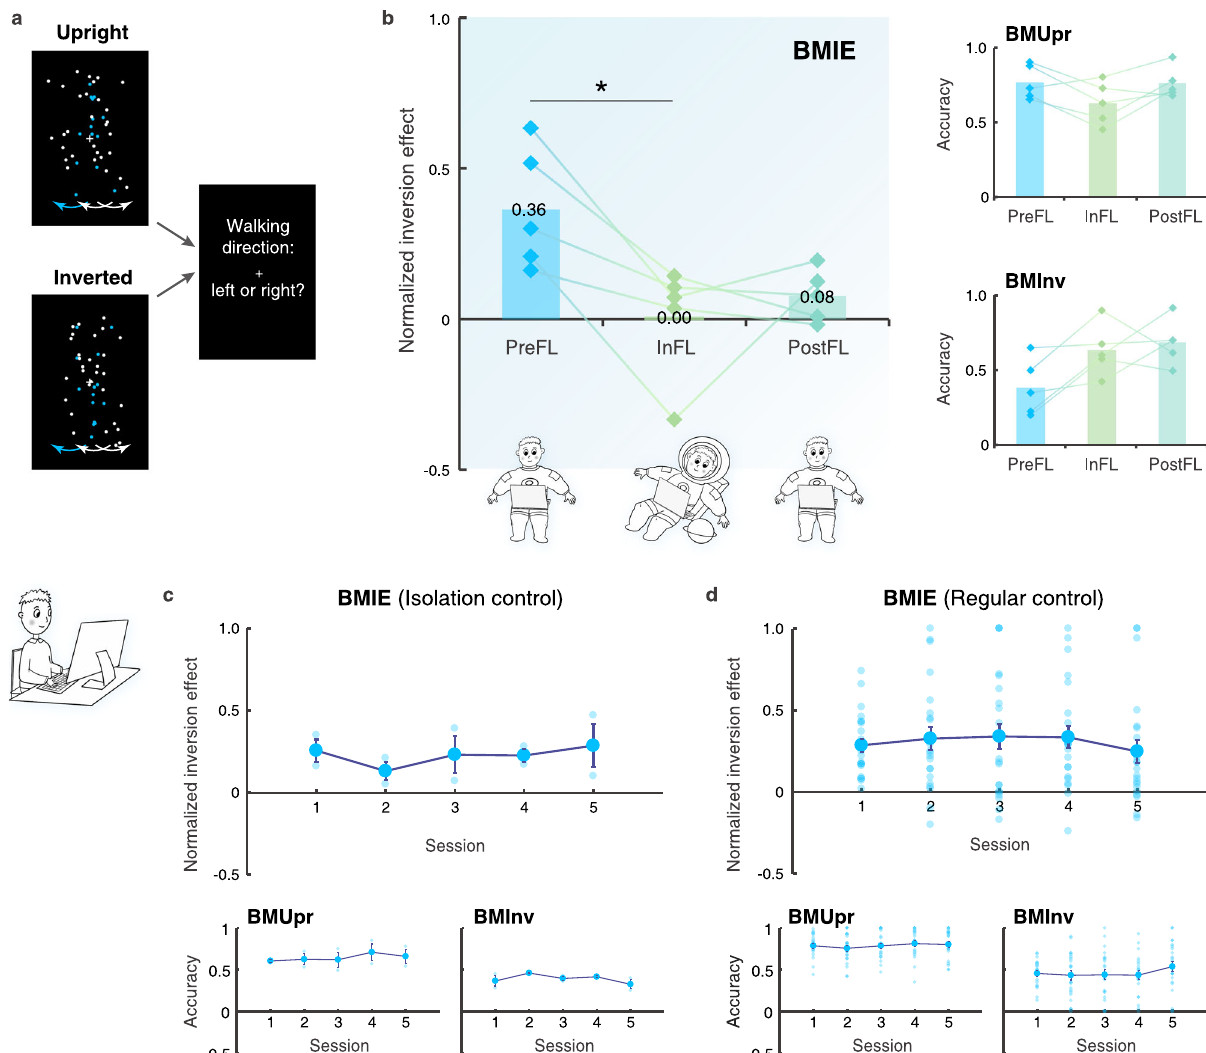
Fig. 2 Experimental design and results for the space experiment and the ground-based control experiments. a Participants judged the walking direction of an upright or inverted point-light walker (rendered in blue for illustration only) embedded in a dynamic mask. The mask consisted of scrambled walkers with balanced left and right walking direction cues. Blue and white arrows represent the walking directions indicated by the target walker and the noise mask, respectively. Demos of sample BM stimuli are provided as supplementary information. b The normalized BM inversion effect (BMIE) and the task performance for the upright (BMUpr) and inverted (BMInv) conditions obtained before (PreFL), during (InFL), and following (PostFL) the space fl ight. Diamonds show individual data ( n = 5). * p = 0.048 (two-tailed paired t -test, Bonferroni corrected). c Results obtained from the isolation control experiment where participants performed the BM perception task before (the fi rst session), during (the second to the fourth session), and after (the fi fth session) 30-day isolation. Blue dots represent individual data ( n = 2). Error bars indicate ±1 SEM. d Results obtained from the regular control experiment where participants performed the BM perception task repeatedly in fi ve test sessions over more than one month (35 days on average). Blue dots represent individual data ( n = 22). Error bars indicate ±1 SEM. Source data are provided as a Source Data fi